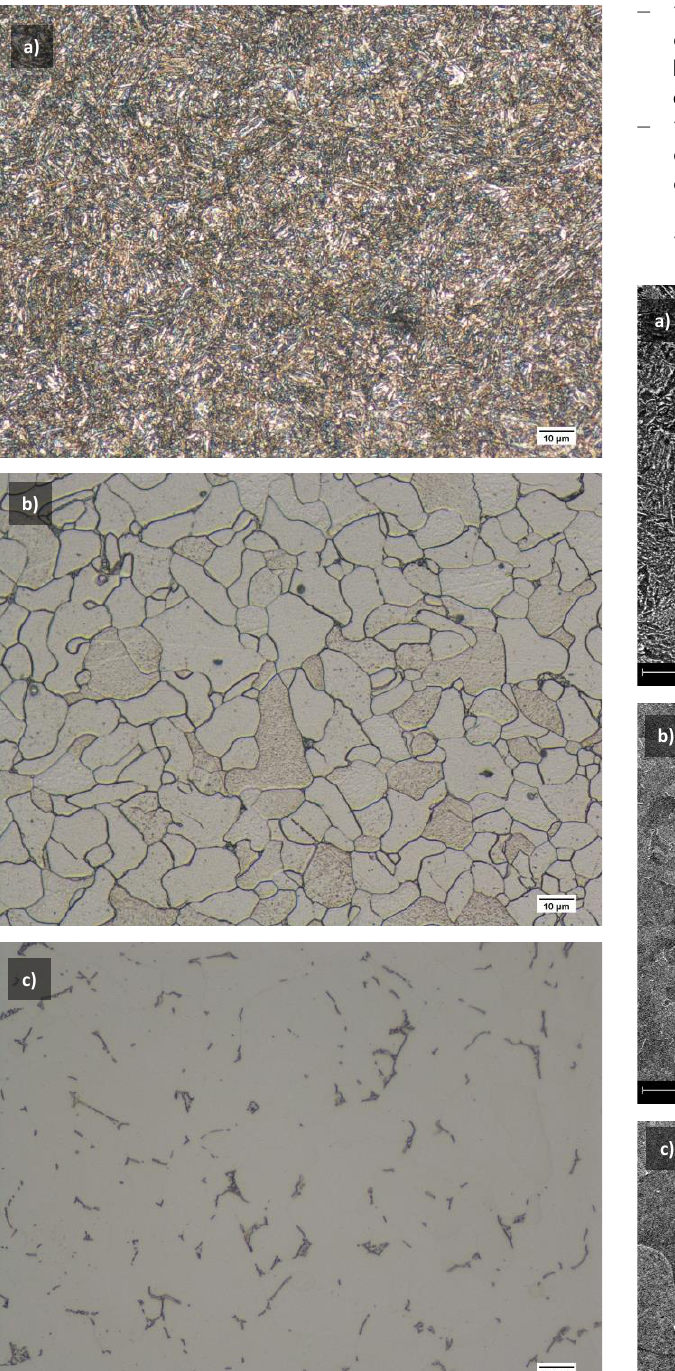
cementite Fig. 2. Snap hook: a) original with tempered martensite microstructure; b) c) imitating original with ferritic microstructure with minor amount of pearlite colonies and presence of tertiary cementite at grain boundaries (micrograph c) in picral-etched state to visualize the extensive amount of cementite) Fig. 3. Snap hook: a) original with tempered martensite microstructure; b) imitating original with ferritic microstructure with minor amount of pearl- ite colonies; c) numerous tertiary cementite precipitations visible at grain boundaries (indicated by arrows); SEM (BSE)